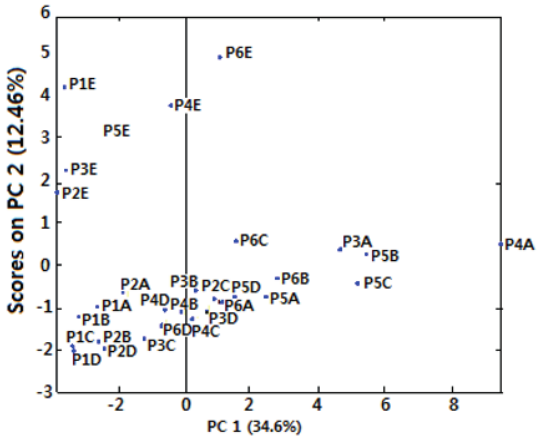
Figure 3 - Scores of water samples collected in different months based on the metal content of the Todos os Santos River.